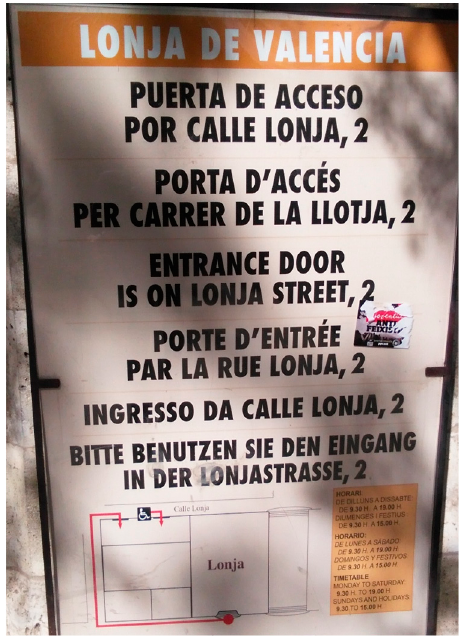
Figure 23. Valencia: Multilingual sign on a traders ’ market .